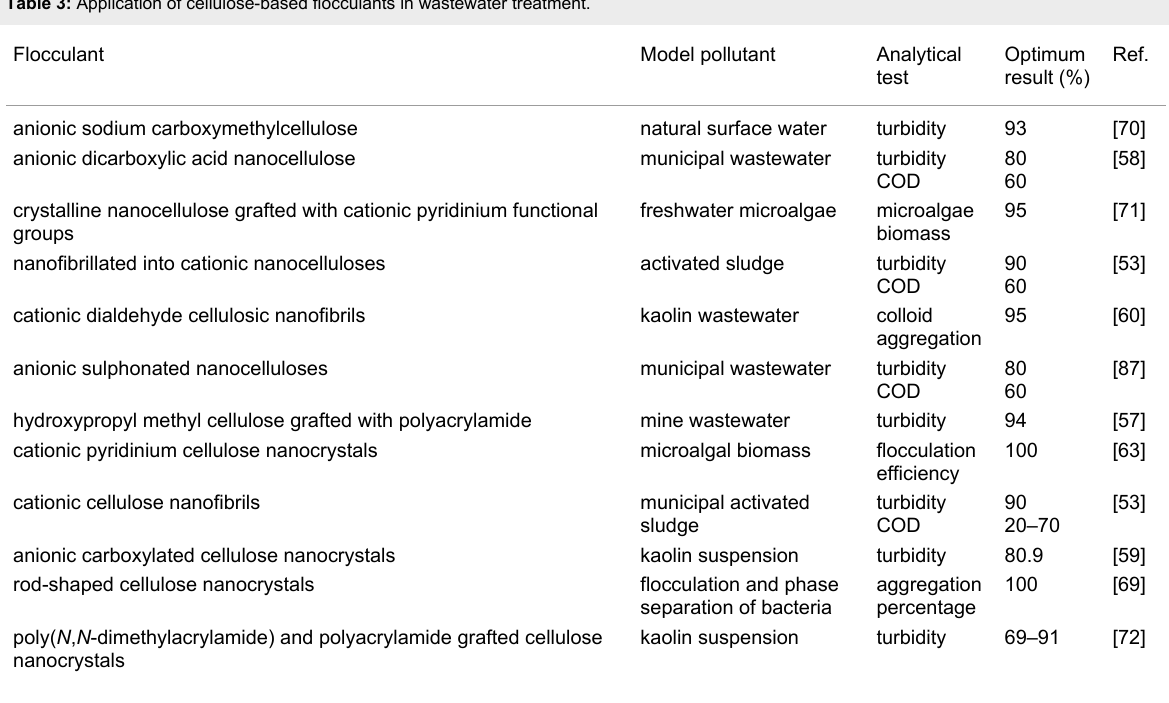
Table 3: Application of cellulose-based flocculants in wastewater treatment.